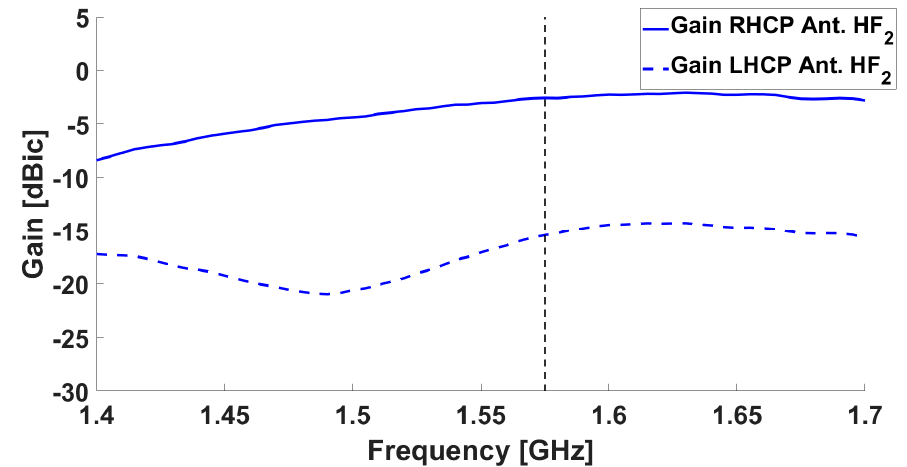
Figure 6. Gain as measured in the Starlab near-field semi-anechoic chamber for one of the lateral antennas: the solid line is the RHCP, while the dotted line is the LHCP.